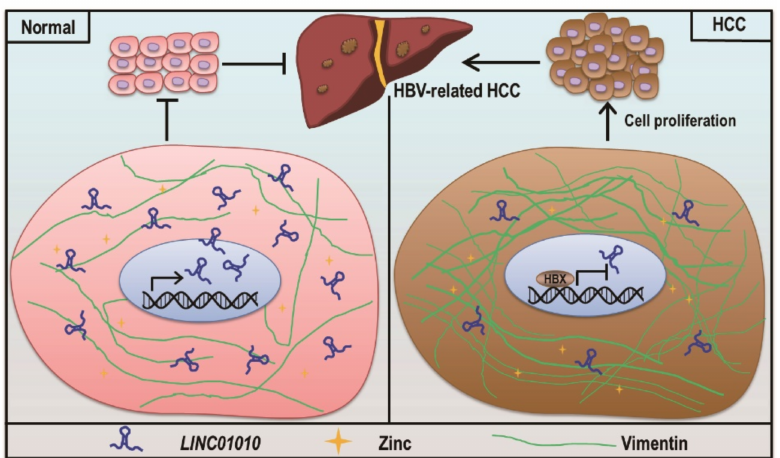
Figure 6. Model of the function of LINC01010 . In normal hepatocyte cells, LINC01010 reduces vimentin filament assembly via interacts with vimentin to attenuate cell proliferation. In HBV- infected cells, HBV-encoded HBx downregulates the transcription of LINC01010 , which in turn promotes cell proliferation, migration and invasion, which may contribute to the development of HBV-related